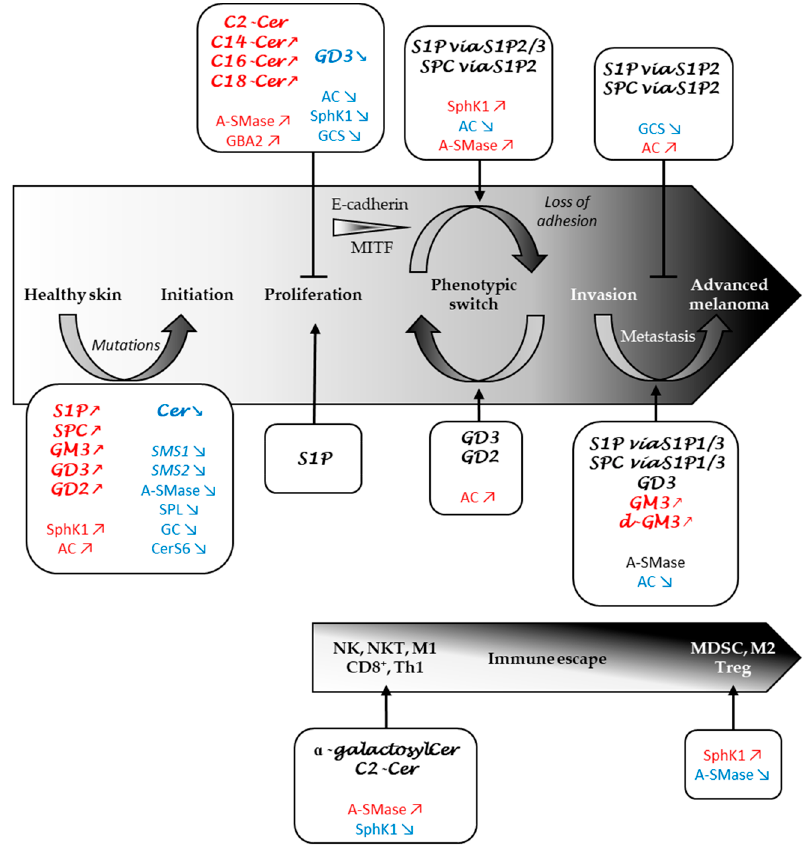
Figure 4. Role of sphingolipid metabolism in melanoma progression and immune response. SL metabolites and SL-metabolising enzymes whose levels and expression are increased, decreased or implicated are marked in red, blue or black, respectively. AC, acid ceramidase; CD8 + , CD8 + T cells; Cer, ceramide; CerS, ceramide synthase; GC, glucosylceramidase; GCS, glucosylceramide synthase; M1, M1 macrophages; M2, M2 macrophages; MDSC, myeloid-derived suppressor cells; NK, natural killer cells; NKT, natural killer T cells; S1P, sphingosine 1-phosphate; S1P1 / 2 / 3, S1P receptor type 1 / 2 / 3; SMases, sphingomyelinases; SMS, sphingomyelin synthase; SPC, sphingosylphosphorylcholine; SphK, sphingosine kinase; SPL, S1P lyase; Th1, Th1 CD4 + T cells; Treg, tegulatory T cells.